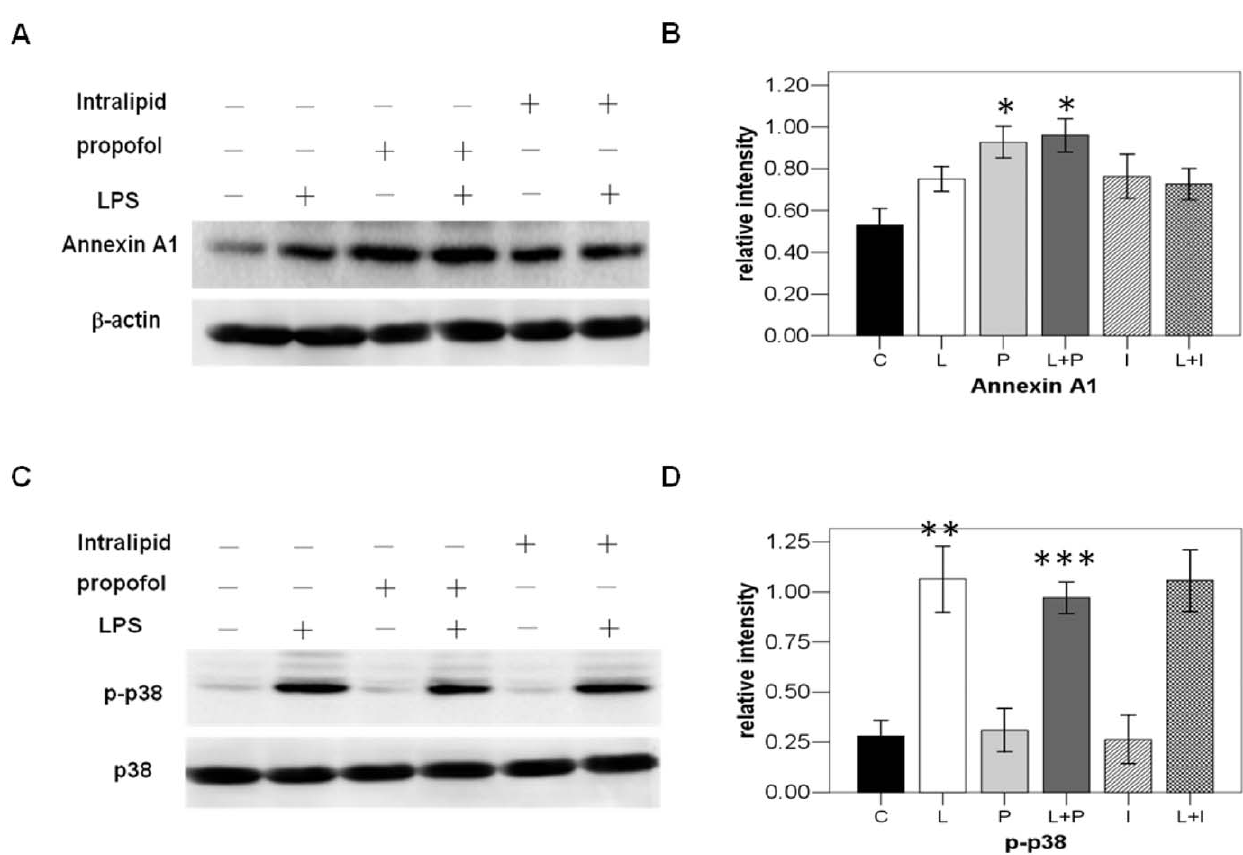
Figure 3. Confirming the expression of Annexin A1 and phos-p38 in monocytes with Western Blot assay. A. Monocytes lysis samples from the individual rats were separated on 12% SDS-PAGE gels and transferred to PVDF membranes for Western blotting analysis. B. Gray intensity analysis of the western blot results of six groups. Each bar represents the mean 6 S.D, (*p , 0.01, n=6, compared with the other four groups) C group: control group; L group: LPS group; P group: propofol group; L + P group: LPS + propofol group; I group: intralipid group; L + I group: LPS + intralipid group. C. Monocytes lysis samples from the individual rats were separated on 12% SDS-PAGE gels and transferred to PVDF membranes for Western blotting analysis. D. Gray intensity analysis of the western blot results of four groups. Each bar represents the mean 6 S.D, (**p , 0.01, n=6, compared with the C, P and I groups; ***p , 0.05, n=6, compared with the L and L + I groups) C group: control group; L group: LPS group; P group: propofol group; L + P group: LPS + propofol group; I group: intralipid group; L + I group: LPS + intralipid group.